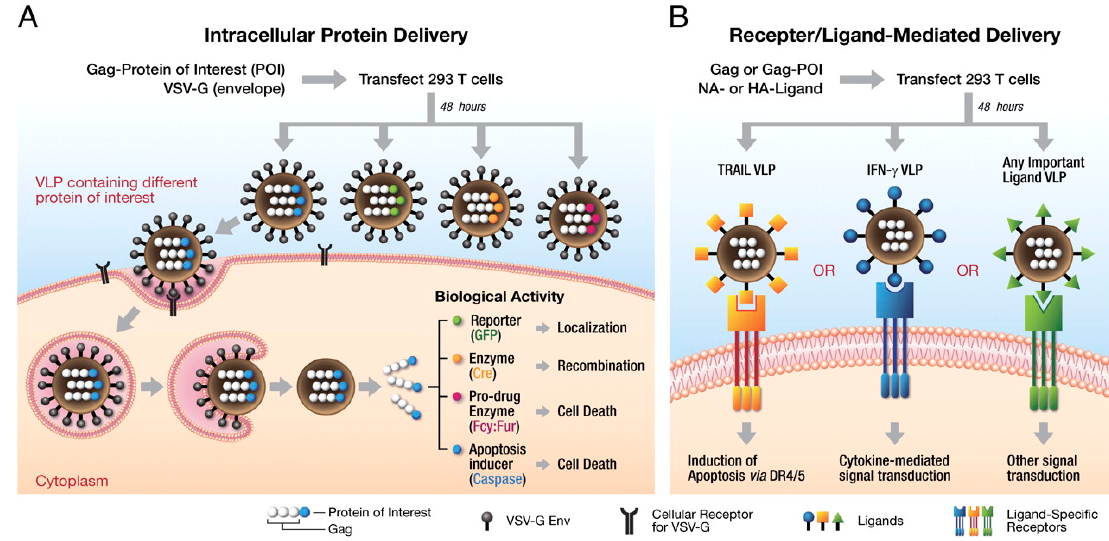
Figure 2. Schematics of the generation of functional virus-like particle (VLP) and ( A ) the delivery of proteins of interest intracellularly, and ( B ) by receptor/ligand-mediated protein delivery. Reproduced with permission from Ref. [57]; Copyright © 2011, National Academy of Sciences.